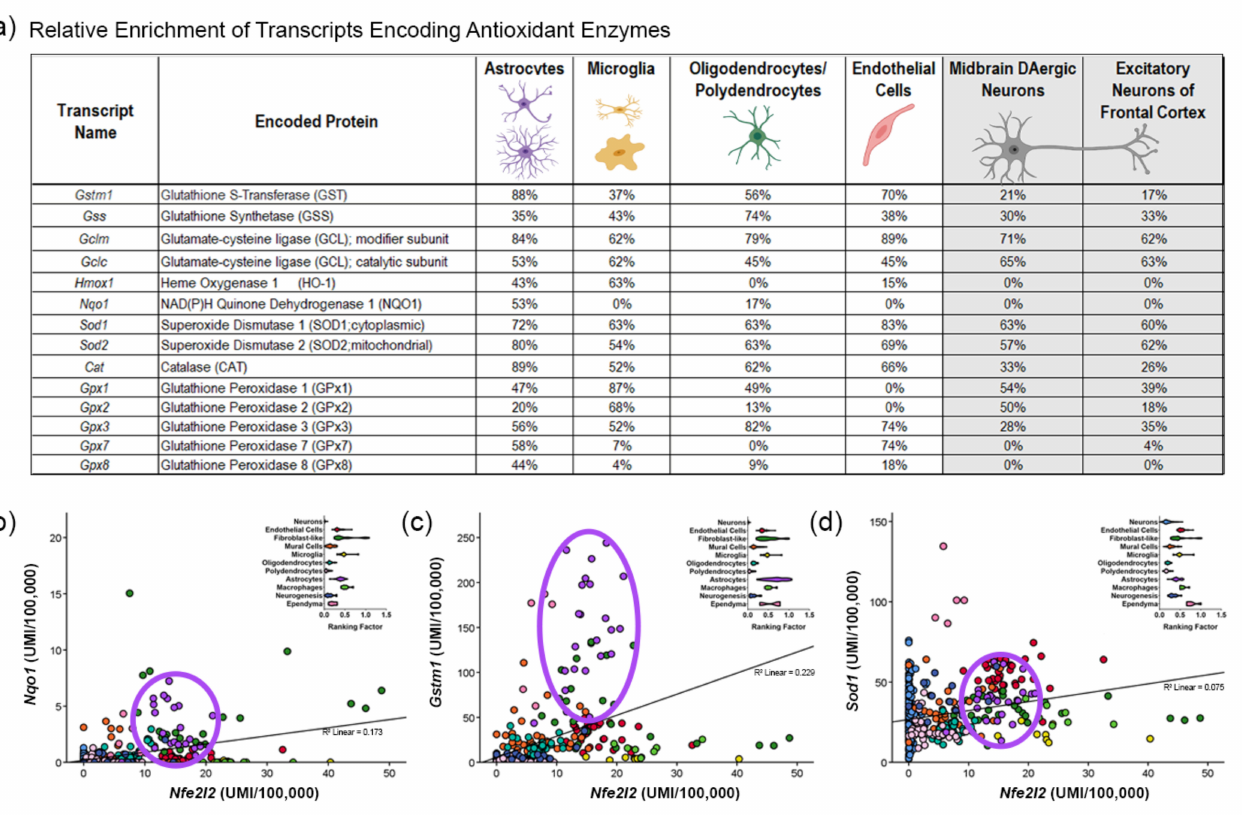
Figure 3. Dropviz.org database [4] was used to demonstrate the cell type-specific differences in downstream transcriptional targets involved in antioxidant defense ( a ); percentages shown in table represent transcript abundance with respect to the highest expressing cell subcluster and relation- ships between transcript abundance of transcriptional regulators (shown in Figure 2). The level of antioxidant response gene expression was explored in ( b – d ). Values are expressed as UMI/100,000 in graphs and as “ranking factor” for cell type-specific patterns of expression in figure insets. Ranking factors were generated by calculating the distance from the origin for each cell type using the equation [x2 + y2] 0.5 , where (x,y) represents UMI/100,000 values normalized to the highest expressing